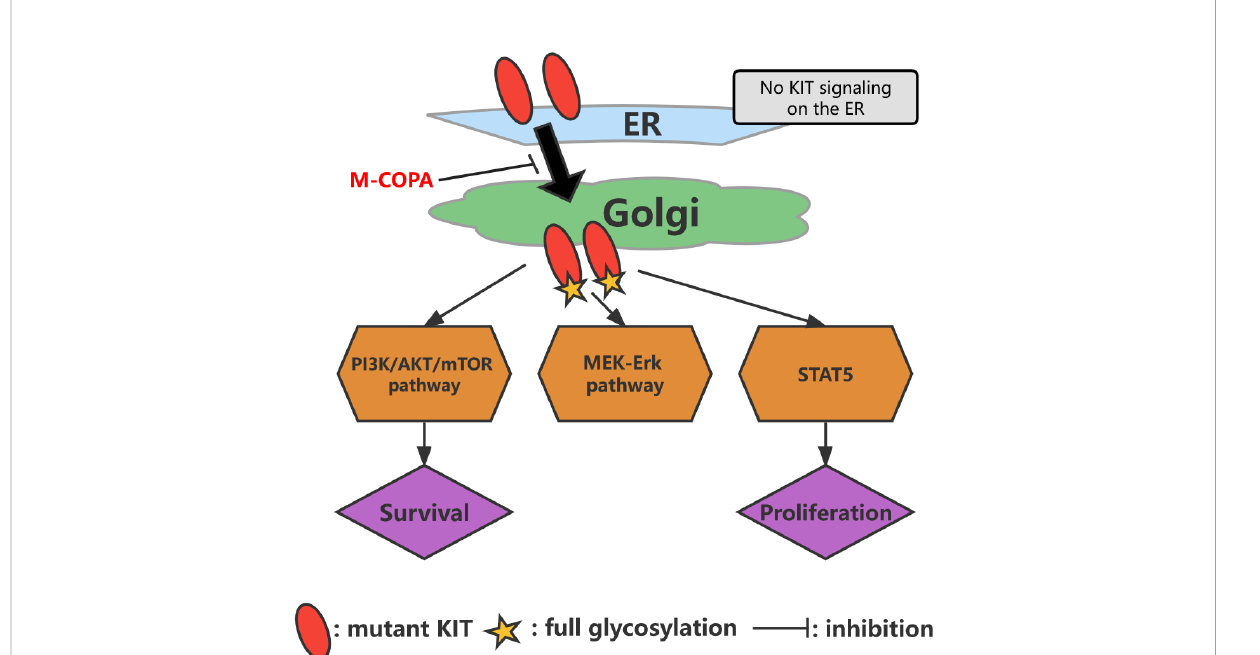
FIGURE 4 Model of oncogenic KIT signaling on intracellular compartments in GISTs. KIT is normally transported from the endoplasmic reticulum to the Golgi apparatus, followed by full glycosylation. After reacting with the Golgi apparatus, KIT can activate the PI3K/AKT/mTOR pathway, MEK-Erk pathway, and STAT5 . M-COPA inhibits oncogenic signaling by blocking the transport of KIT from the endoplasmic reticulum to the Golgi because KIT activates downstream molecules only on the Golgi